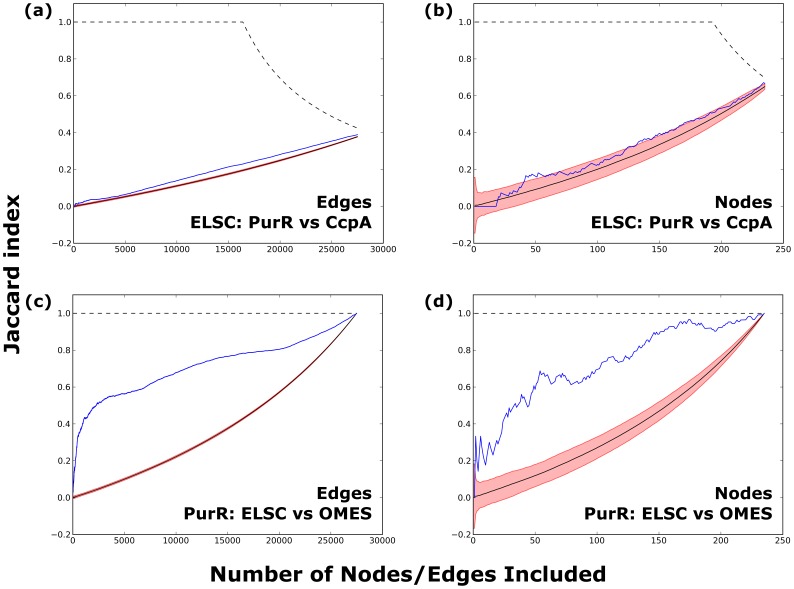
Jaccard analyses.The Jaccard index comparing the set of N most highly-scoring edges (panel a) or nodes (panel b) between PurR and CcpA is shown as a function of threshold N (blue lines). The example shown is for ELSC; all other algorithms and comparisons to all other subfamilies are in Figures S2–S6 in Data S1 and Figures S18–S22 in Data S4. For reference, plots show the Jaccard indices expected for (i) random overlap (solid black line) ±95% confidence intervals (red region) and (ii) perfect agreement (dotted black line); at large N, the line for “perfect agreement” falls below 1 because the PurR and CcpA MSAs do not have identical lengths and the number of conserved positions differ. Comparsion of the PurR and CcpA subfamilies reveals little similarity, though more than expected by chance alone. For comparison, significant similarity was seen for the nodes (c) and edges (d) when results from two algorithms (ELSC and OMES) were compared for one subfamily (PurR). Similar plots and conclusions were obtained when McBASC, OMES, SCA and ZNMI were used to compare all pairs of subfamilies.